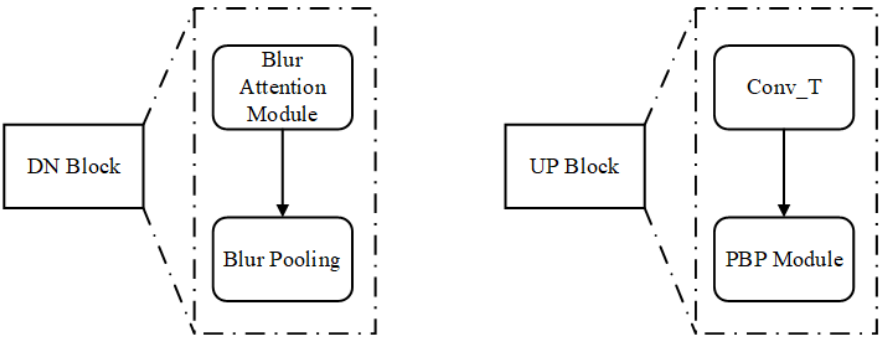
Figure 4. Block diagram of DN block ( left ); block diagram of UP block ( right ).